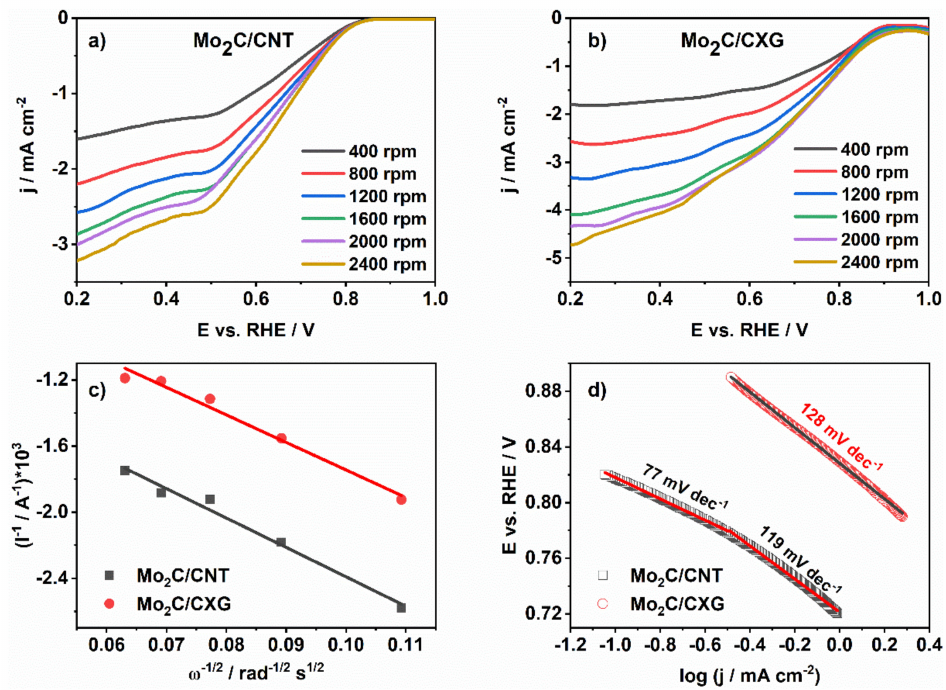
Figure 5. Linear scan voltammograms (LSVs) at di ff erent rotation rates for ( a ) Mo 2 C / CXG and ( b ) Mo 2 C / CNT in O 2 -saturated 0.1 M NaOH with ( c ) Koutecky–Levich (K–L) analysis and ( d ) Tafel analysis of oxygen reduction reaction (ORR) at tested